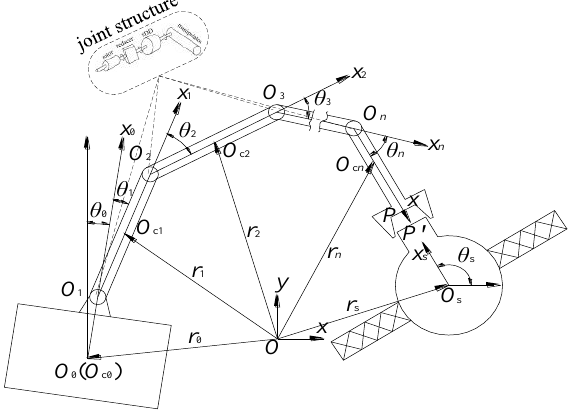
Figure 3. Space robot with SDD and target satellite systems.